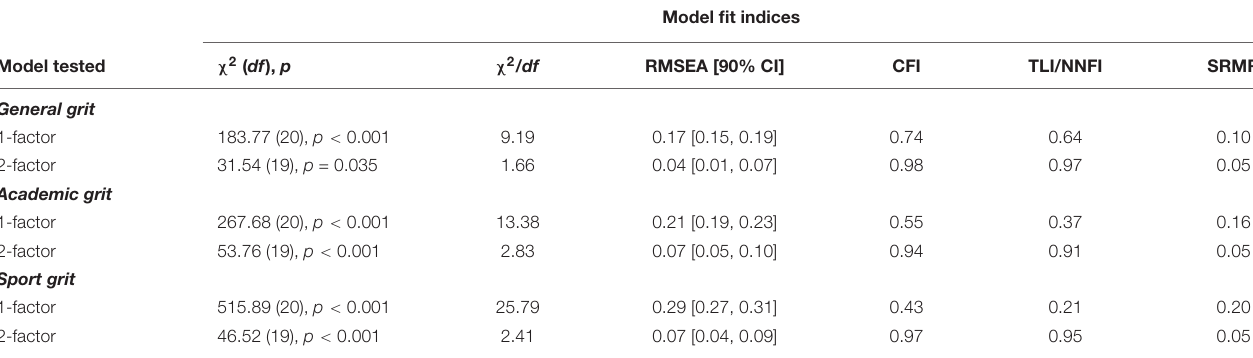
TABLE 1 | Fit indices following maximum likelihood confirmatory factor analyses for grit